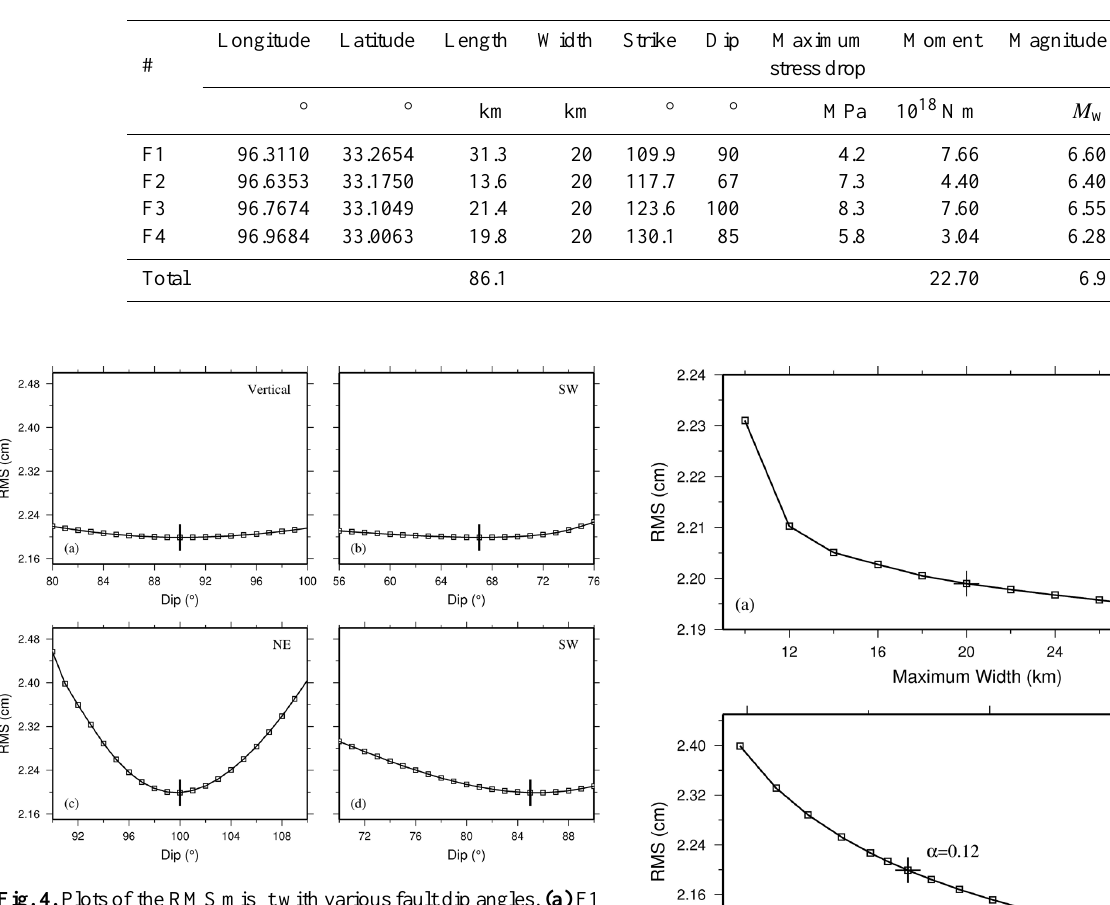
Fig. 4. Plots of the RMS misfit with various fault dip angles. (a) F1 segment, (b) F2 segment, (c) F3 segment and (d) F4 segment. The dip angle of each fault segment is varied at 1 ◦ interval while fixing other parameters in searching for best fitting fault dips. The text in upper-right corner indicates the dip direction of each fault segment.